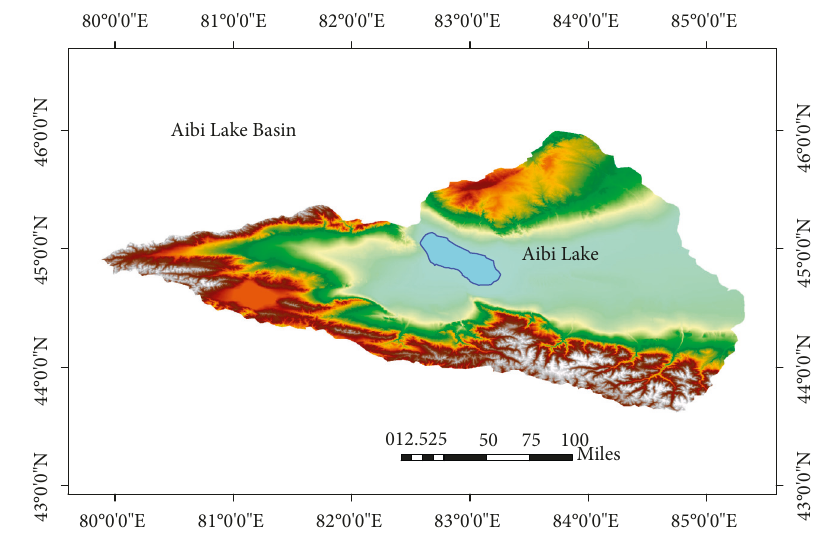
Figure 1: Map of the study